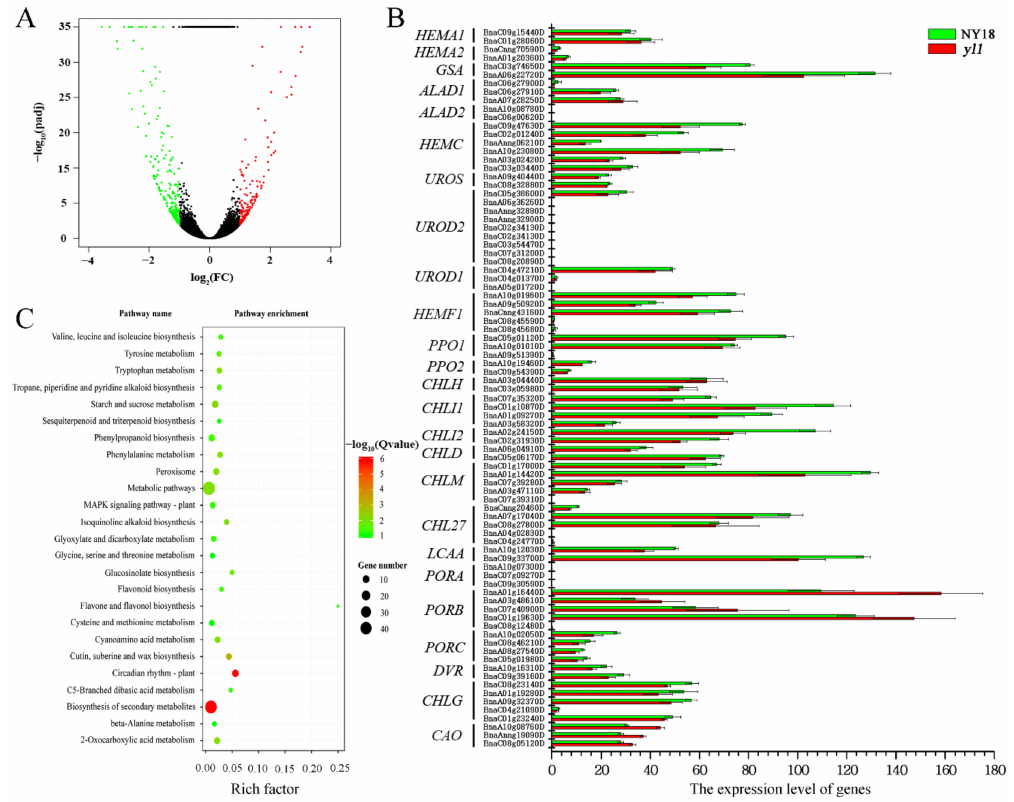
Figure 4. ( A ) Differentially expressed genes (DEGs) between yl1 and NY18. ( B ) The expression level of genes involved in chlorophyll biosynthesis pathway. ( C ) KEGG pathway categories of differentially expressed genes between NY18 and yl1 at leaves from the seedling stage. The size of the point represents the number of genes, and the color of the point represents the degree of